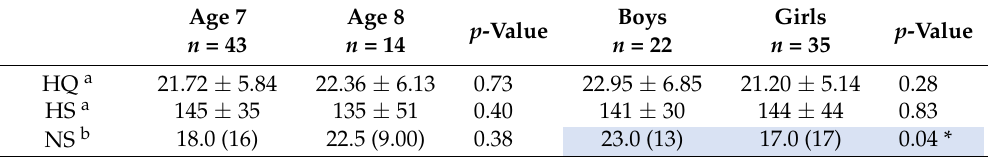
Table 1. Handwriting product and process characteristics according to age and